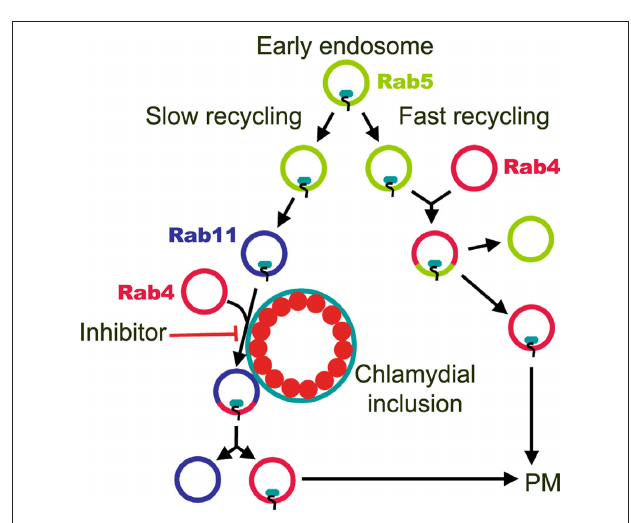
Figure 8 | The effect of Fr179254 can be reversed by omission of the transferrin-containing fraction of serum from the medium. Infected cells were treated with or without FR179254 (FR) and cultured in the presence or absence of serum or serum fractions as described in Section “Materials and Methods.” IFUs were collected and quantified. Red bars indicate no